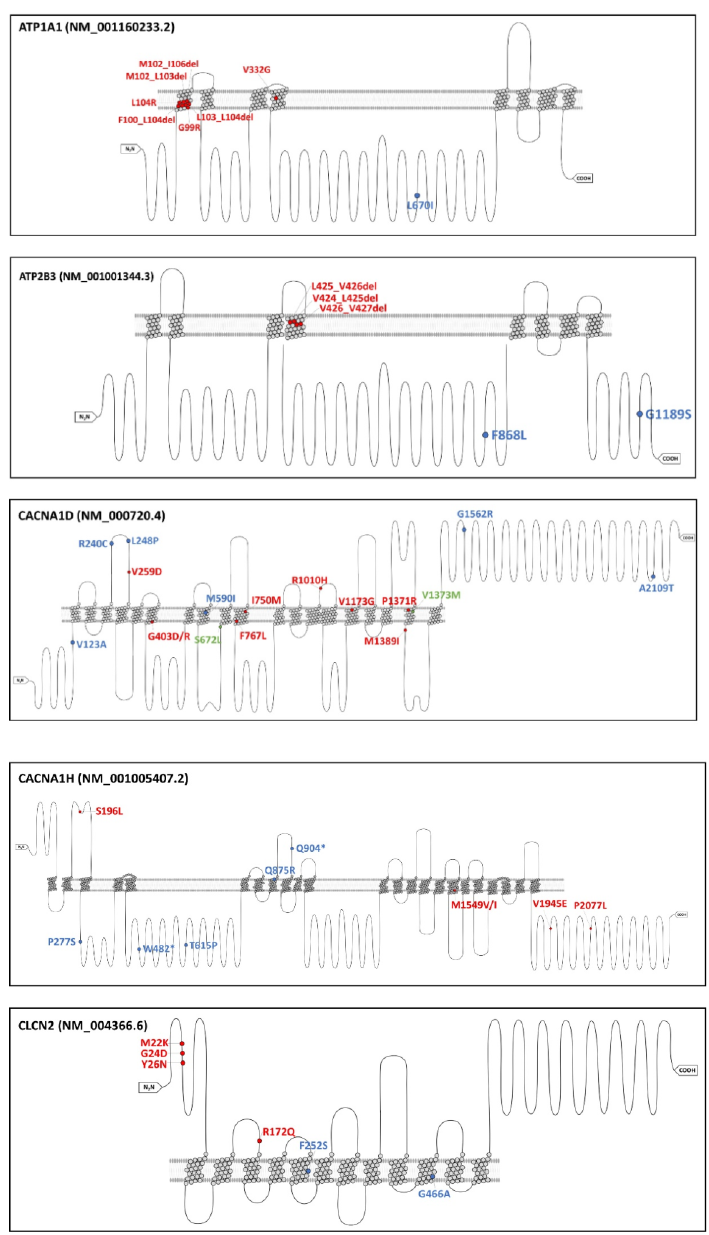
Figure 2. Genetic mutations identified in unilateral primary aldosteronism via targeted next- generation sequencing. Proteins were visualized with a Protter tool (Bioinformatics, Volume 30, Issue 6, 15 March 2014, Pages 884–886). Red font indicated the known hotspot mutation position that